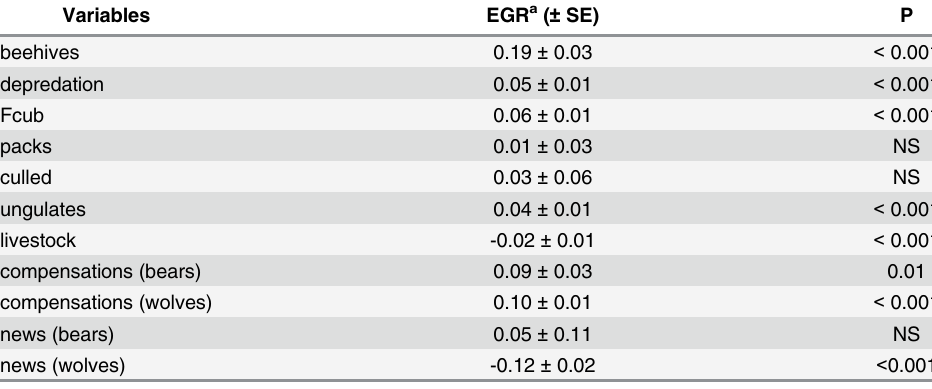
Table 2. Trends in the variables used in the